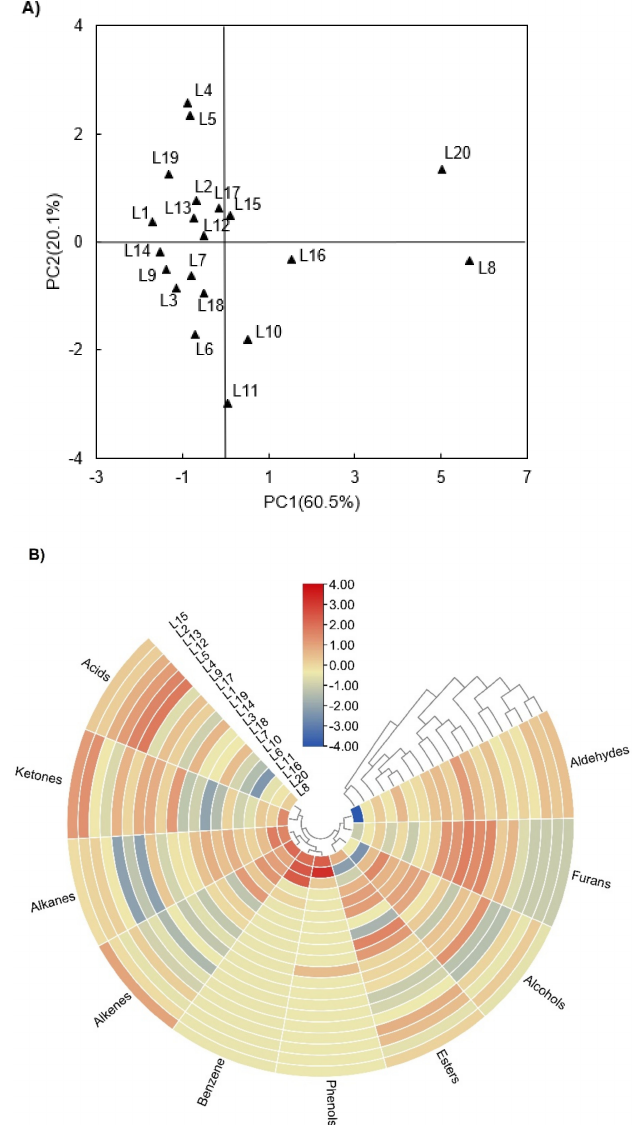
Figure 3. Principal component analysis and heatmap analysis of volatile compounds of VCO from 20 geographic regions. ( A ) Score plot of principal component analysis of all volatile compounds data of Camellia oleifera seed oil. ( B ) Heat map analysis of Camellia oil using the main types of f volatile composition